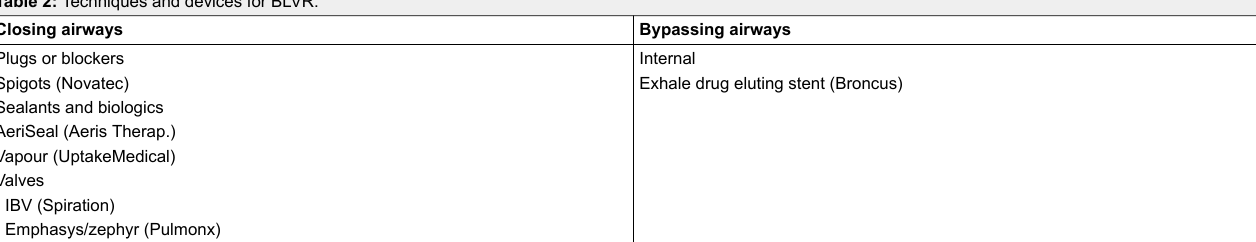
Table 2: Techniques and devices for BLVR. Closing